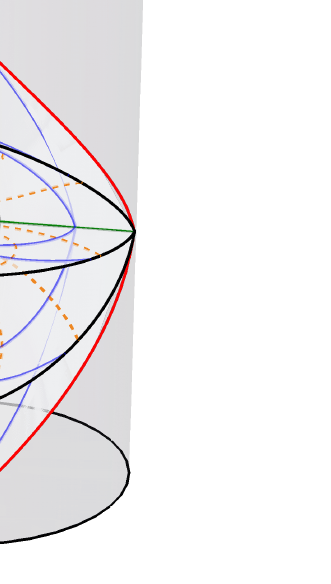
Figure 11 . The rapidly accelerating light conical deficit with A > ‘ − 1 , pushed by a strut, embedded within global AdS 3 . The deficit’s worldline is shown in solid black. Several surfaces of constant t are plotted. The event horizon is demonstrated by the surfaces at early and late t . The bifurcation surface is shown as a green line. A “wedge” is removed, with its faces x = x + and x 0 = x + identified. These faces are indicated by long-dashed black curves within each time-slice, and in dashed red at the boundary. The boundary of the classically accessible subset of the global boundary is shown in solid red. Lines of constant x are shown in blue, with lines of constant y in dashed orange. To guide the eye, the axis of the cylinder is also shown in